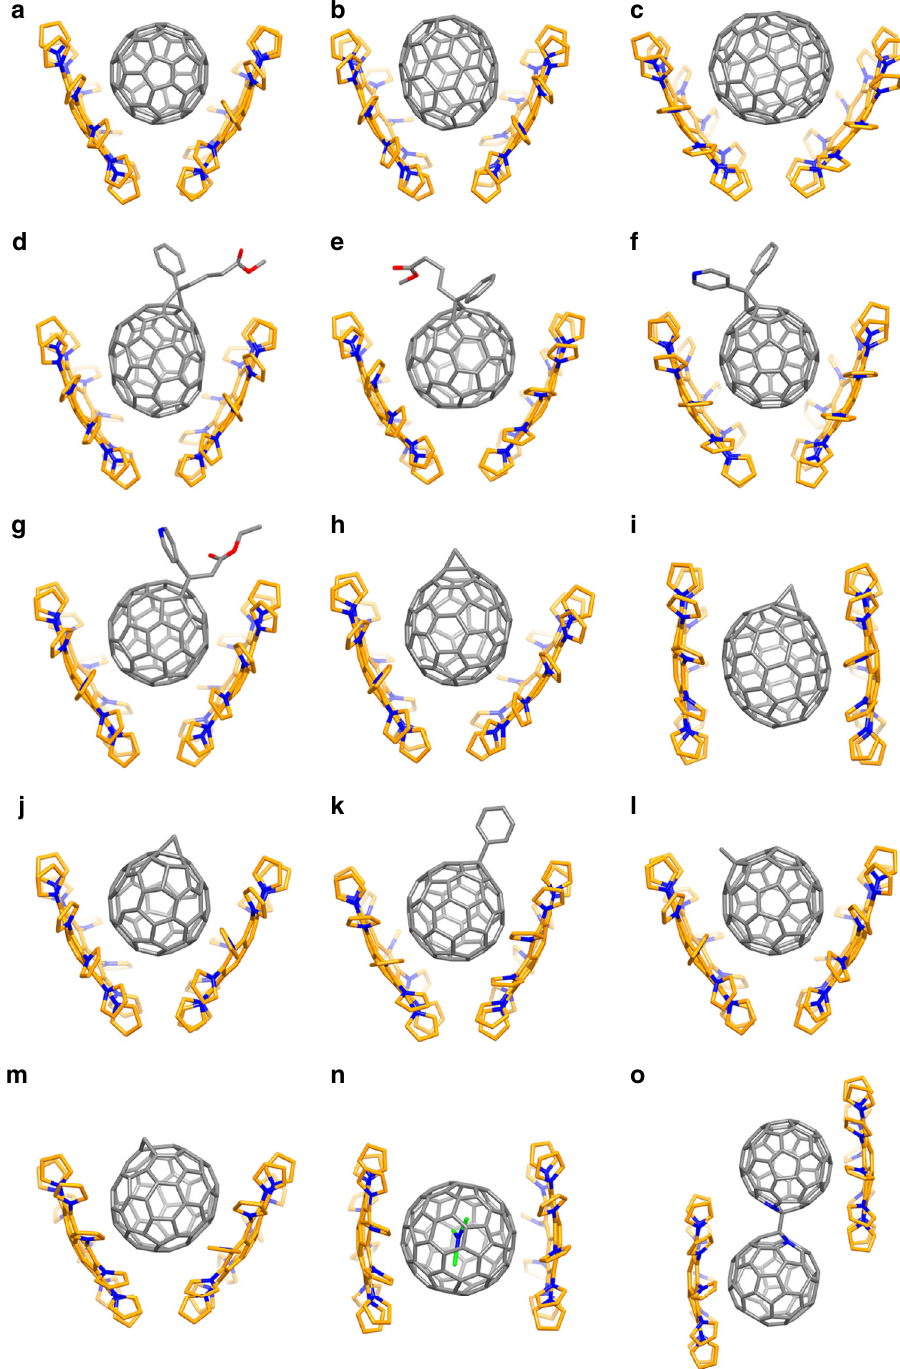
Fig. 4 Crystallographic structures of co-crystals between DPC ( 2a ) and fullerenes. a 2DPC{C 60 }, b 2DPC{C 70 }, c 2DPC{C 90 }, d 2DPC{ α -PC 71 BM}, e 2DPC{ β 1 -PC 71 BM}, f 2DPC{PC 61 P}, g 2DPC{PC 61 AE}, h 2DPC{ C s -C 71 H 2 -I}, i 2DPC{ C s -C 71 H 2 -II}, j 2DPC{C 65 H 6 }, k 2DPC{C 60 HPh}, l 2DPC{C 60 HCH 3 }, m 2DPC{